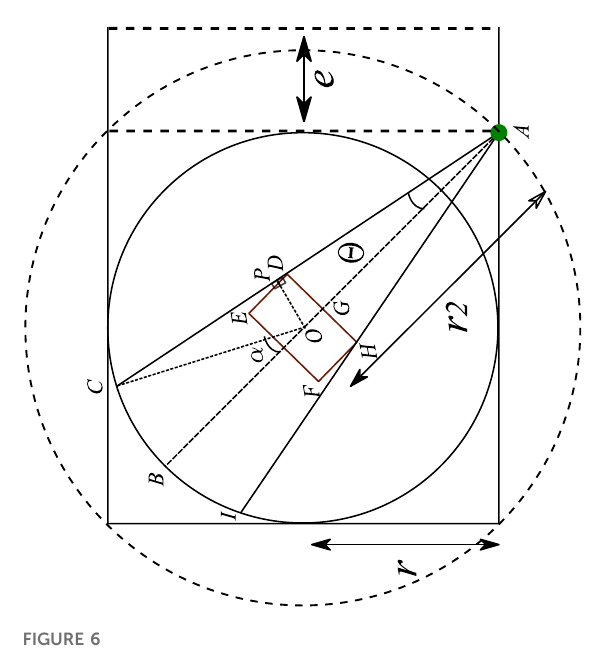
FIGURE 6 Constrained occlusion with the sensor at the